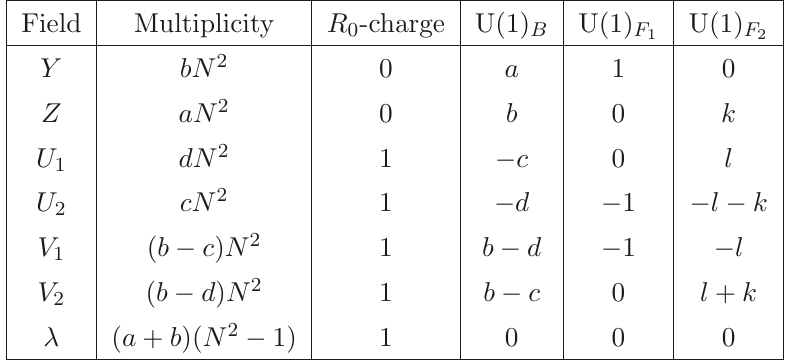
Table 2 . The field content of the L a,b,c quiver